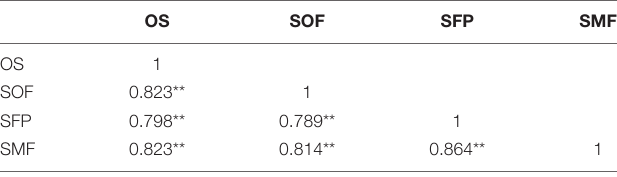
TABLE 5 | Correlation analysis results of each